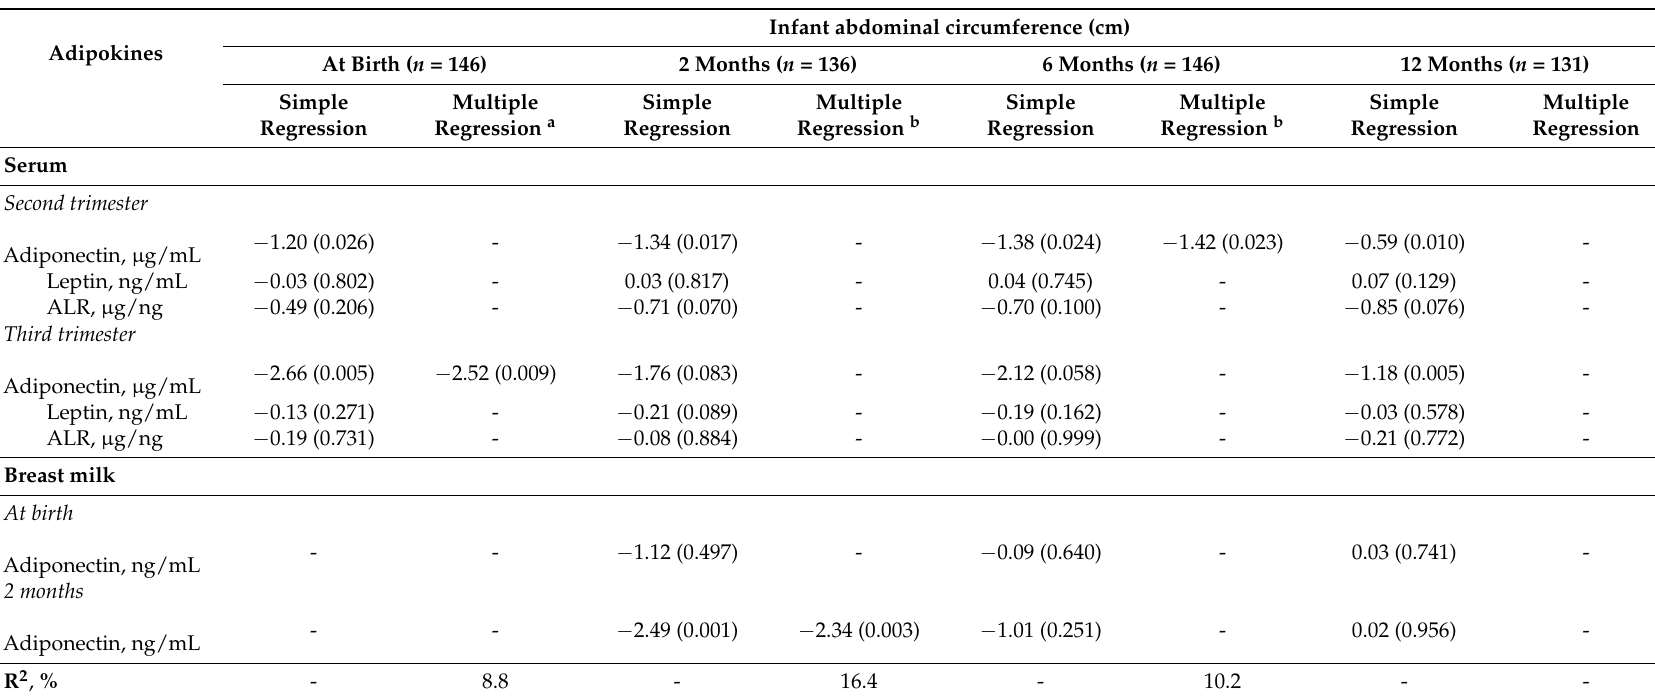
Table 5. Regression coefficients ( p -value) of maternal serum and breast milk adipokines on infant abdominal circumference. Infant abdominal circumference (cm) Adipokines At Birth ( n = 146) Simple Multiple Simple Multiple Simple Multiple Simple Multiple Regression Regression a Regression Regression b Regression Regression b Regression